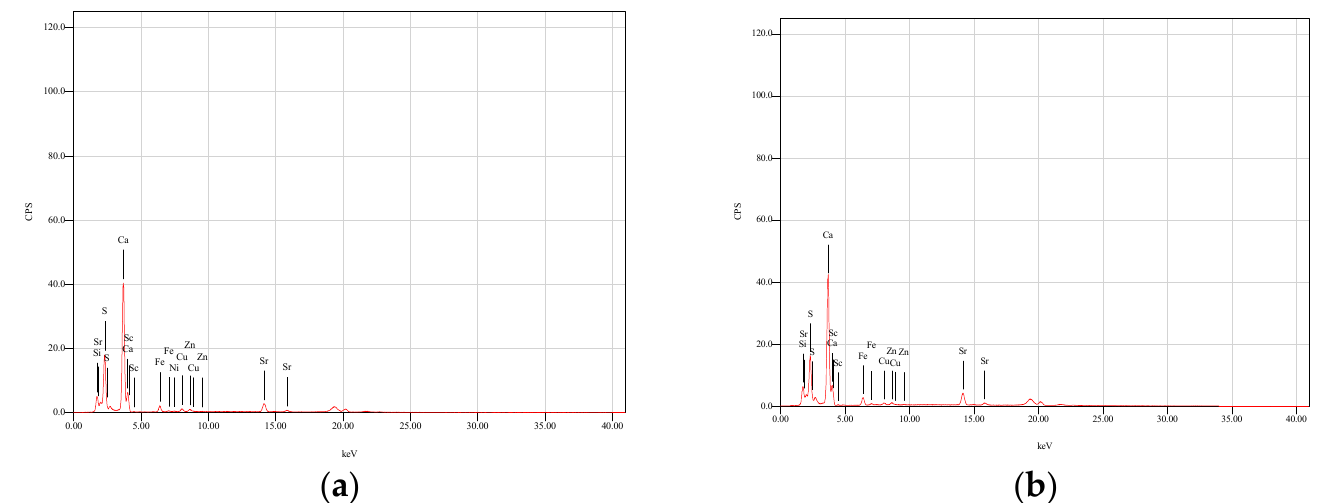
Figure 6. XRF analysis of phosphate waste after ( a ) 30 min of treatment and ( b ) 40 min of treatment.